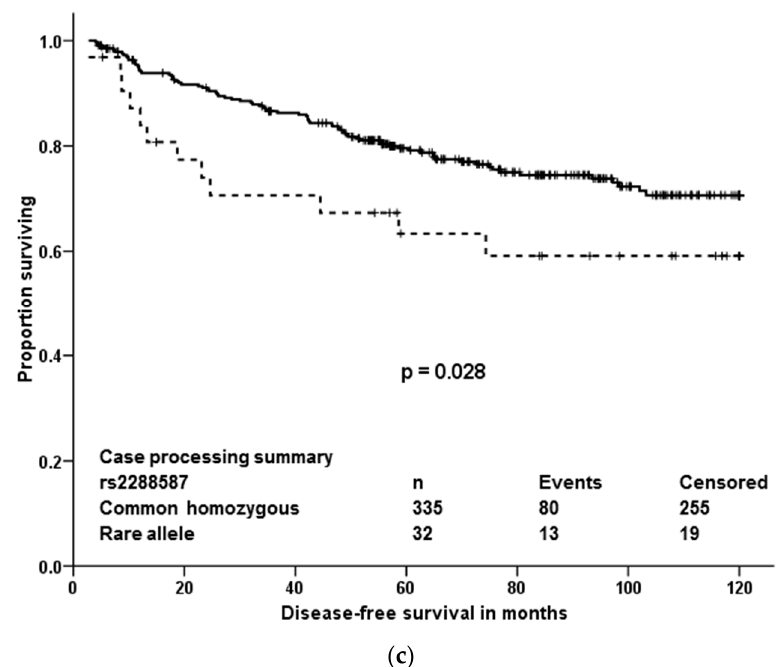
Figure 4. Kaplan-Meier plots with validated associations of variants with DFS of patients treated with cytotoxic therapy. Solid line represents the common homozygous genotype and dashed line the rare allele. Significance was evaluated by the log-rank test, n = number of individuals. In the absence of rare homozygotes in any of the compared groups, effect of rare allele was evaluated. ( a ): rs1801160; ( b ): rs17376848; ( c ): rs2288587.